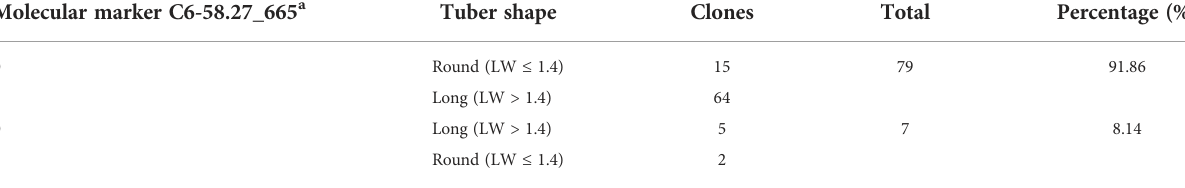
TABLE 4 Evaluation of molecular markers C6-58.27_665 in the natural population. Molecular marker C6-58.27_665